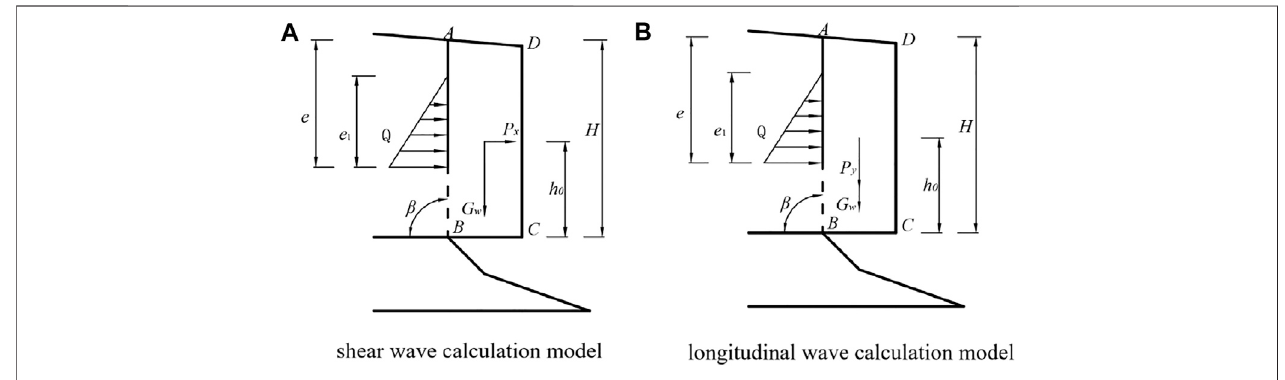
FIGURE 2 | Slope calculation